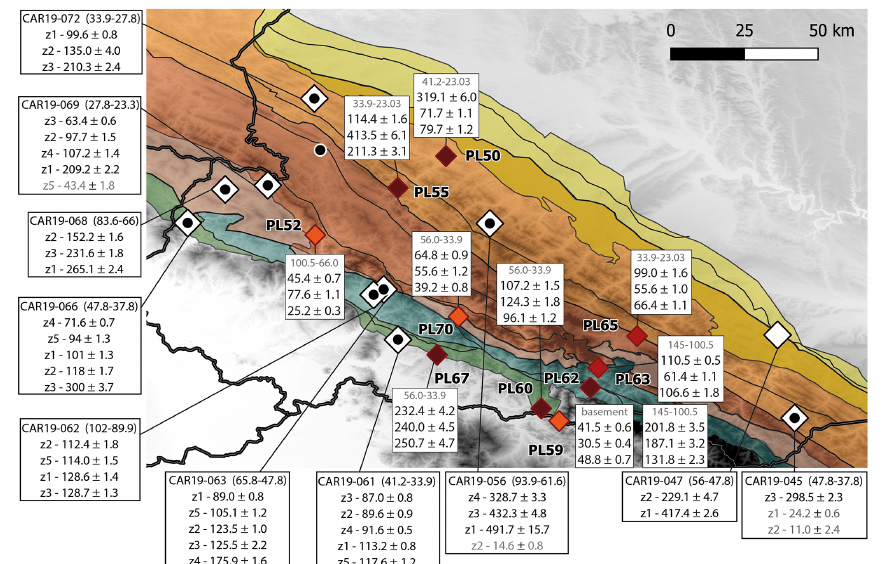
Figure 5. Zircon (U–Th) / He ages in the Ukrainian Carpathians. The symbols and color scale for the data are as indicated in Fig. 3. Single- grain ages, corrected for α ejection, from this study are detailed next to the map frame (numbers in parentheses next to sample code denote the depositional age range). Previously published data (Andreucci et al., 2015) are reported on the map as follows: depositional age range, average age and associated uncertainty, maximum single-grain age, minimum single-grain age. Ages in grey are interpreted to be outliers and are not used in the models or in our